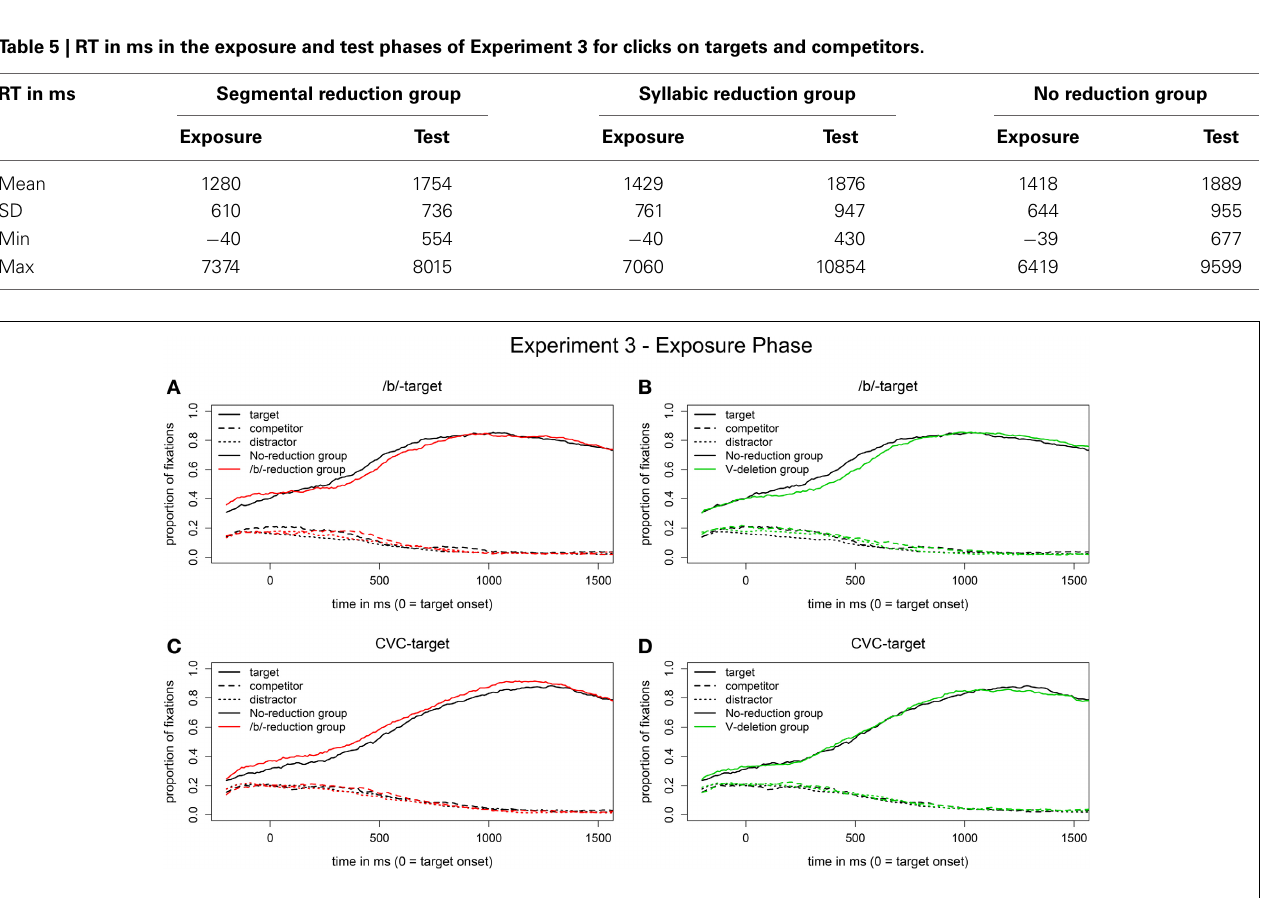
were reduced only for the /b/-reduction group (segmental reduction group) and the CVC-words were reduced only for the V-deletion group (syllabic reduction